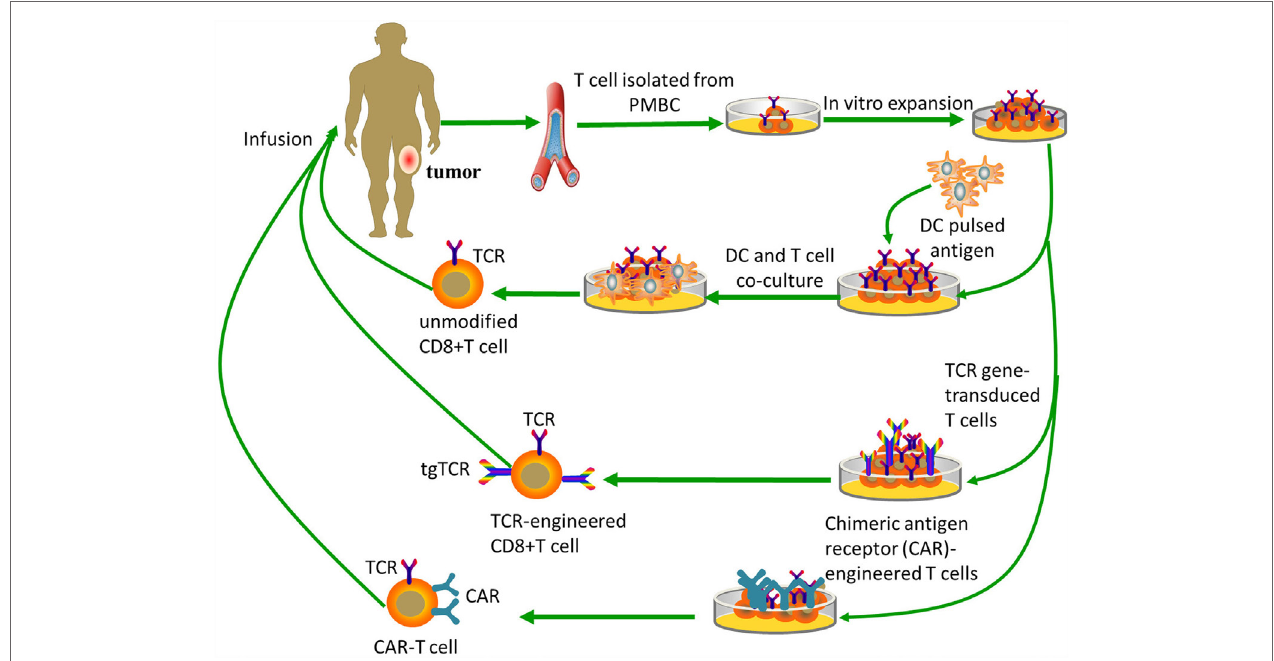
FiGURe 2 | Tumor-specific T-cell-based immunotherapy . Unmodified CD8 + T cells are ex vivo expanded and do not need genetic modification, while both TCR-engineered CD8 + T cells and CAR-T cells need specific modifications to obtain targeting abilities. Unmodified CD8 + T cells need antigen processing and MHC presentation via antigen-presenting cells, such as dendritic cells. TCR-engineered CD8 + T cells can directly recognize intact target molecules expressed on tumor cell surface in an MHC-dependent fashion, while CAR-T cells are